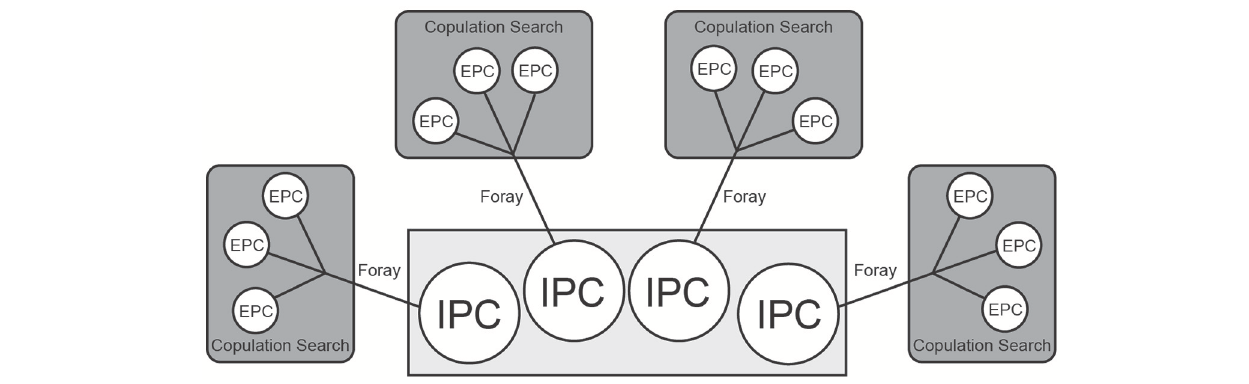
FIGURE 1 | Conceptual diagram of the model portraying the tradeoff between intra-pair copulations (IPC) and extra-pair copulations (EPC). The Monte Carlo method limited us to treating each of the four IPC-EPCs tradeoffs as discrete points in time. In each simulation, the focal male could gain a maximum of 12 EPC offspring (each representing an independent chance), at the potential cost of up to four IPC offspring. A foray refers to each time that the focal male left his territory and risked one IPC for up to three EPCs. Each foray resulted in a copulation search, which refers to the three opportunities to gain up to three EPC offspring.